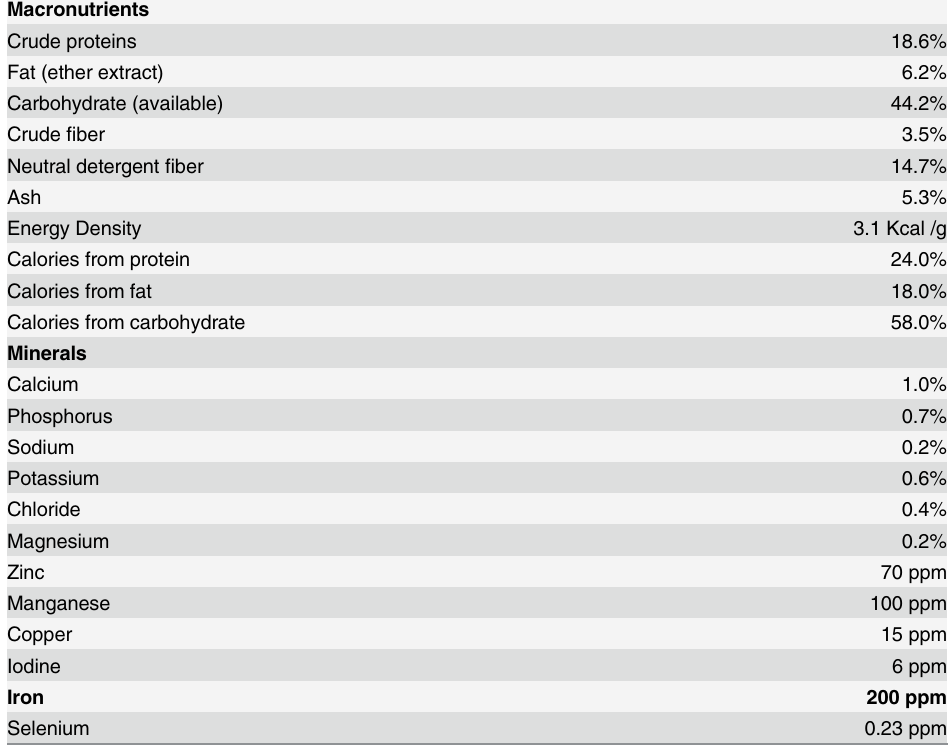
Table 1. Standard control diet ¥ . The high-iron diet consists of 200 mg iron/kg diet (standard control diet) plus 3 mg polymalthosed iron, administered orally.